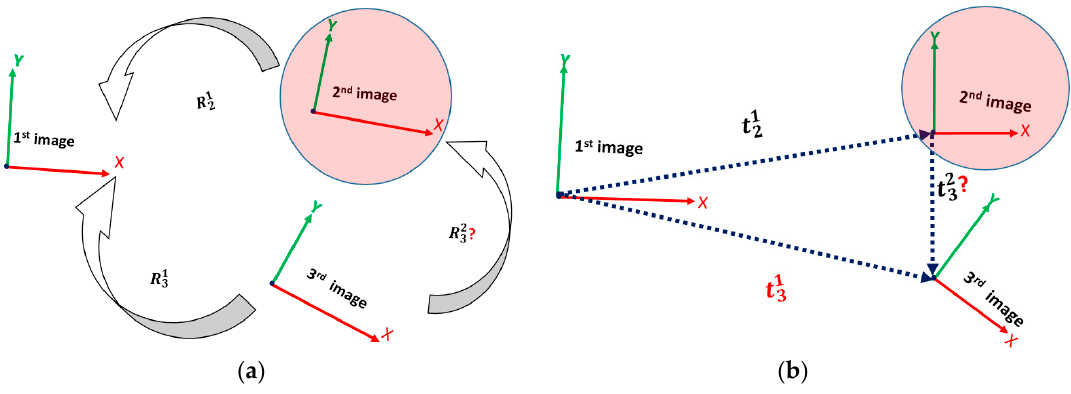
Figure 5. ( a ) Modified SfM Rotation, ( b ) Modified SfM Translation.